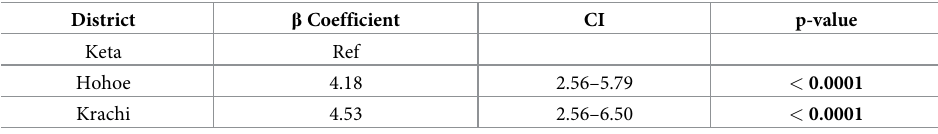
Table 4. Association between malaria transmission and antibody breadth score. District β Coefficient CI p-value Keta Ref Hohoe 4.18 2.56–5.79 < 0.0001 Krachi 4.53 2.56–6.50 < 0.0001 Multiple linear regression adjusting for age and ethnicity was used to generate coefficient and